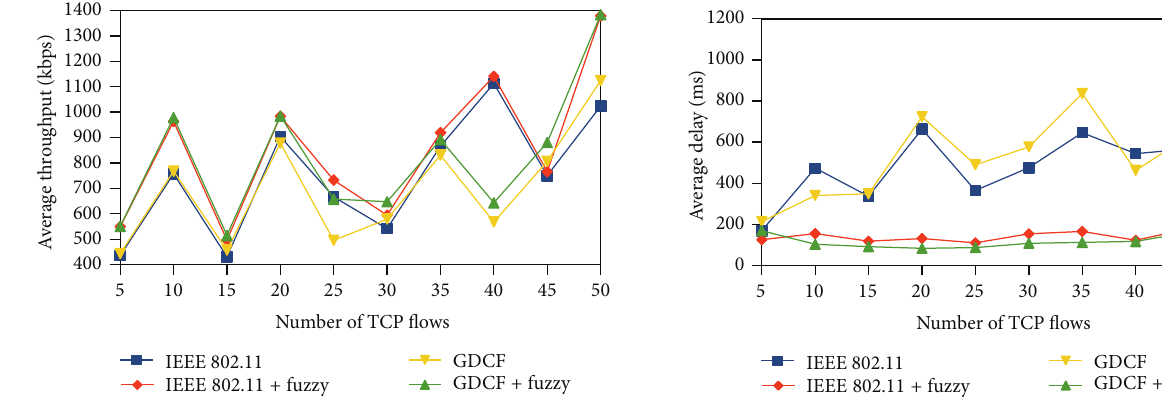
Figure 11: Average end to end delay for 500 ∗ 500